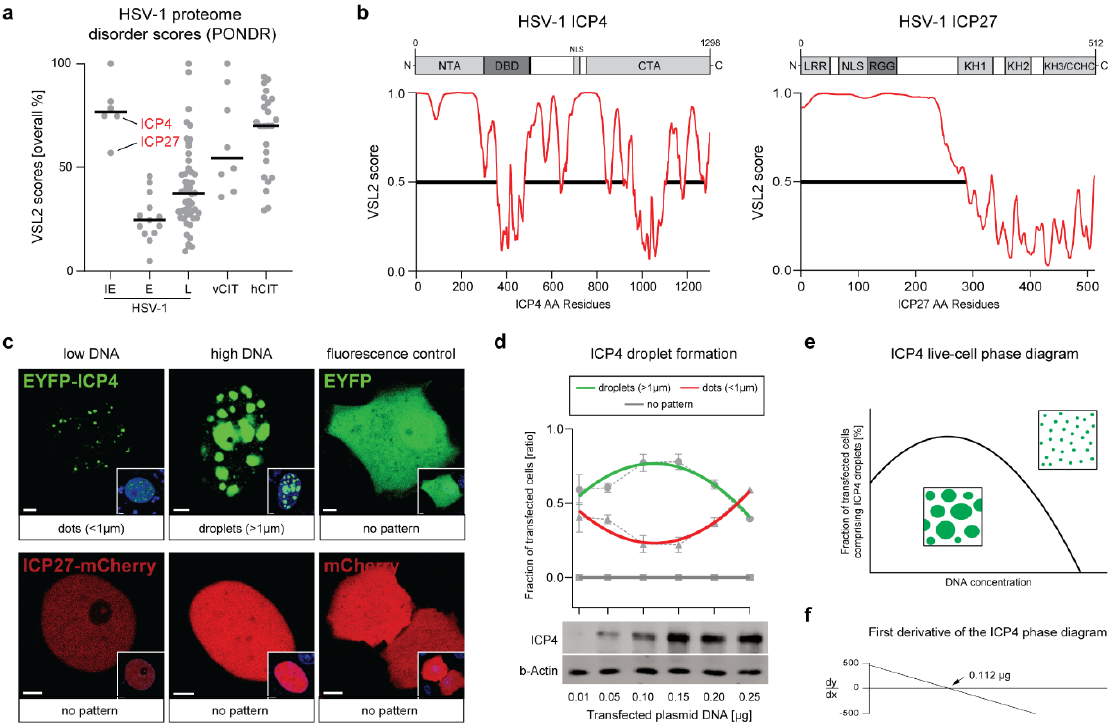
Figure 1. The HSV-1 transcription factor ICP4 is a viral IDP that drives the formation of nuclear condensates. ( a ) HSV-1 proteome screening for intrinsically disordered proteins (IDPs). A total of 71 HSV-1 proteins were screened for the presence of intrinsically disordered regions (IDRs) using the VSL2 algorithm from the online platform PONDR (see also Table S2). VSL2 scores of each protein are plotted as overall percentage disorder. The HSV-1 proteins are separated according to their kinetic expression profile: immediate–early (IE), early (E), and late (L) proteins. A selection of cited viral (vCIT) and human (hCIT) IDPs that phase-separate are shown as a reference (see also Tables S1 and S3). The two essential IE proteins, ICP4 and ICP27, are highlighted. Black bars represent the mean overall percentage VSL2 scores. ( b ) The VSL2 disorder score profiles of ICP4 and ICP27. The relevant protein domains of both proteins are shown above the corresponding VSL2 profiles. The IDRs are highlighted with horizontal black lines. Abbreviations: NTA, N-terminal activation domain: CTA, C-terminal activation domain; DBD, DNA-binding domain; NLS, nuclear localization signal; LRR, Leucine-rich region; RGG, Arg-Gly-Gly box; KH1/2/3, K-Homology domains 1/2/3; CCHC, Cys/Cys/His/Cys Zn-finger domain; ( c ) ICP4 but not ICP27 forms condensates in the nuclei of transfected cells. Vero cells were transfected with either pIE3-EYFPICP4 or mCherry2-ICP27 using two different plasmid DNA concentrations: 0.01 (low DNA) and 0.15 µg (high DNA). At 16 hpt, the cells were counterstained with Hoechst 33342 and processed for live cell imaging using a CLSM. Single z-scans of representative cell nuclei are shown. The plasmids expressing EYFP or mCherry (0.15 µg each) were used as negative controls. Scale bars: 3µm (ICP4 and ICP27), 5 µm (EYFP), and 10µm (mCherry); ( d ) The formation of ICP4 droplets is dose-dependent. Vero cells were transfected with different amounts of pIE3-EYFPICP4 (0.01, 0.05, 0.1, 0.15, 0.2, and 0.25 µg). At 16 hpt, the fraction of cells comprising ICP4 droplets, dots, or no pattern was determined for each transfection (dashed grey line). The graph represents data from three independent experiments where 50–100 transfected cells were counted. Regression curves for each category (green, red, or grey lines) were evaluated using Prism (GraphPad). Western blot analysis was performed in order to confirm the different ICP4 protein levels in transfected cells. The EYFP-ICP4 fusion protein was detected with a monoclonal antibody against ICP4 (ICP4). The beta-actin protein levels served as a loading control (b-Actin); ( e ) The droplets regression curve from panel ( d ) was used to derive the complete ICP4 live-cell phase diagram. The region below the curve represents the conditions that favor de-mixing of ICP4 into droplets. ( f ) The first derivative of the ICP4 phase diagram revealed that the summit of the curve is defined at the DNA amount 0.112 µg.